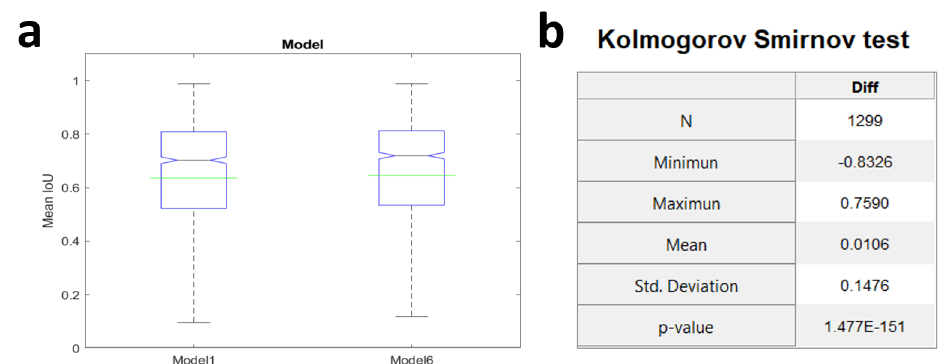
Figure A3. Box plot and normality test of the difference of both models. ( a ) Box plot, green line indi- cates the mean in both graphs, and gray line indicates the median.Model1, N = 1299, mean = 0.6358, median = 0.7027, std. deviation = 0.2289, variance = 0.0540. Model6, N = 1299, mean = 0.6464, median = 0.7197, std. deviation = 0.2300, variance = 0.0529. ( b ) Normality test on the difference of methods (Model 6–Model 1). The p -value obtained was 1.48E-151 less than the significance value of 0.05, so the null hypothesis was rejected and the alternative hypothesis H1 was accepted (data did not come from normal distribution). Once the alternative hypothesis was accepted, Wilcoxon signed ranks test was used to evaluate both methods.